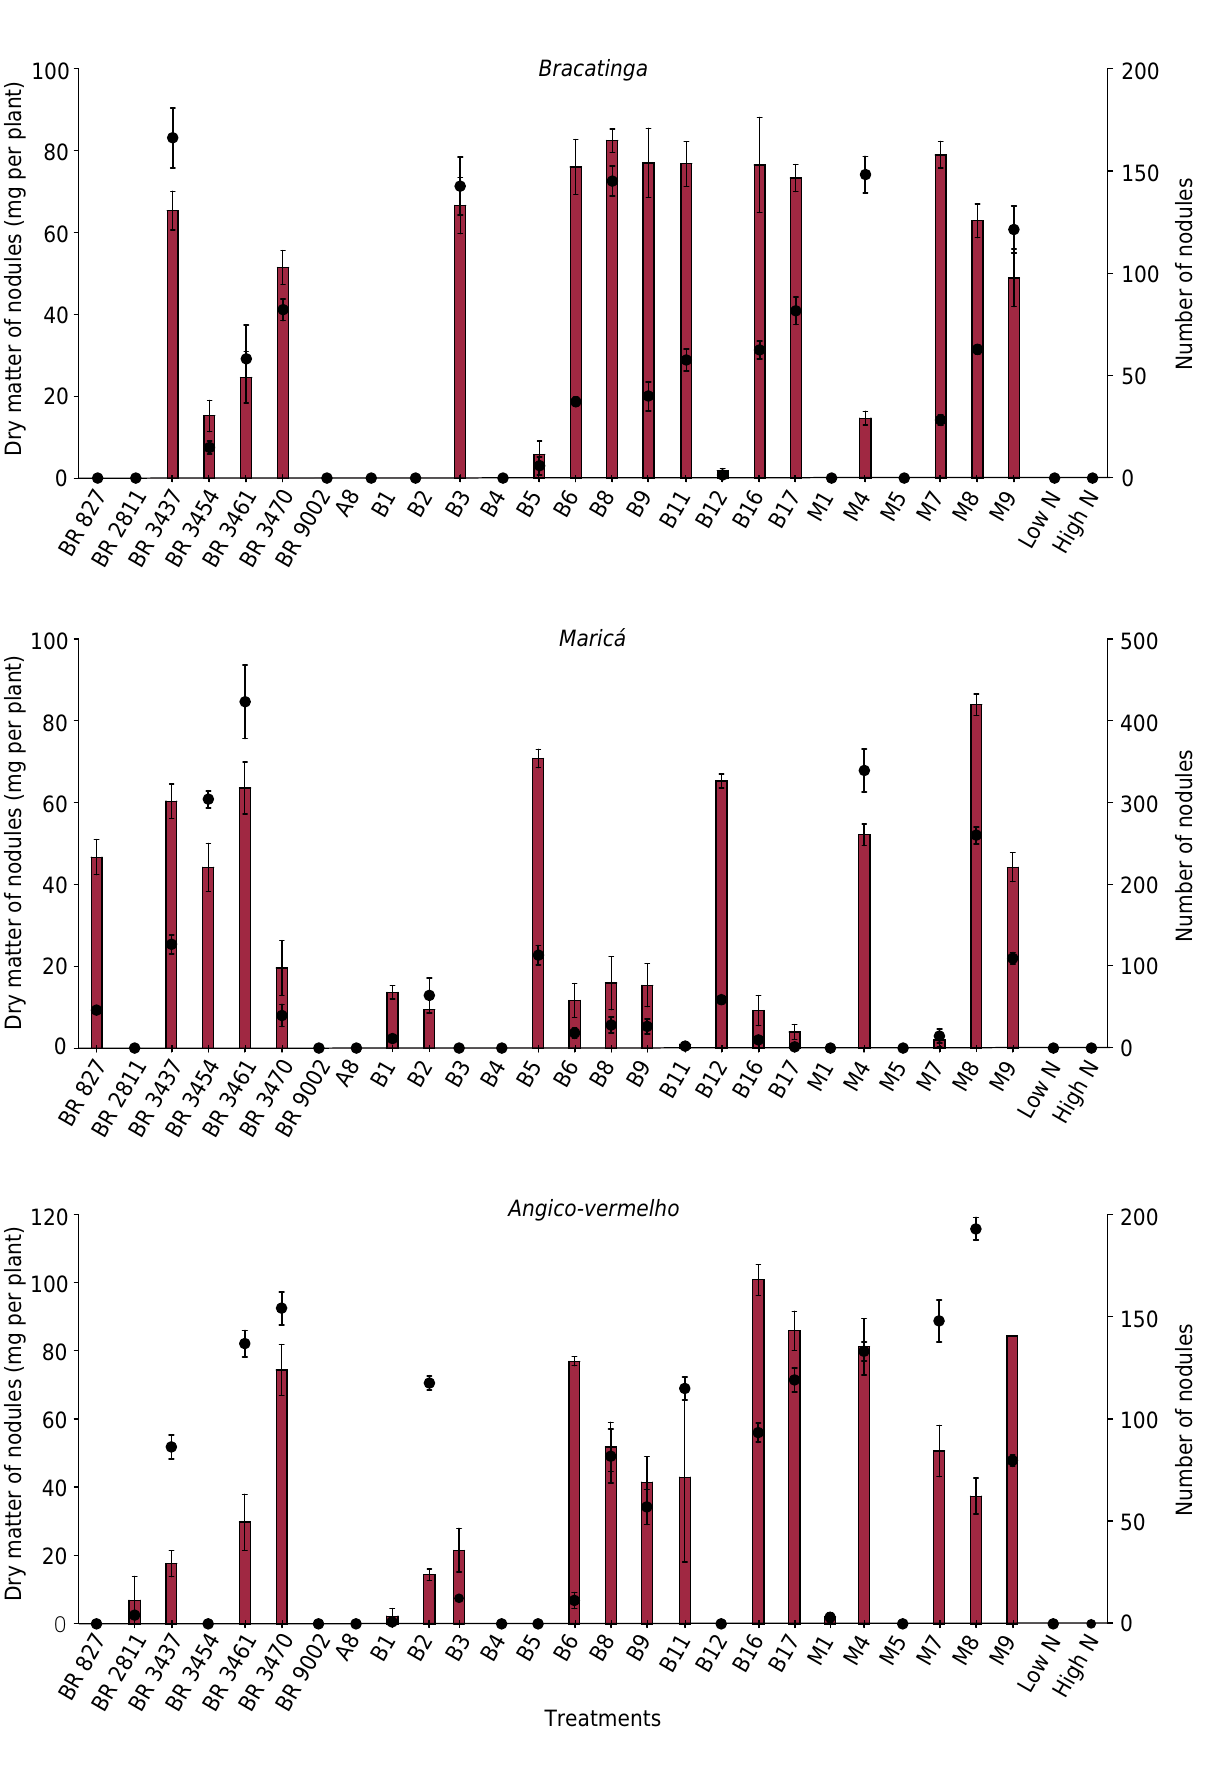
Figure 2. Dry matter (magenta bars) and number of nodules (black circles) from seedlings of bracatinga , maricá and angico-vermelho inoculated with rhizobia indigenous to coal mining areas or with the recommended strains of reference. Vertical bars represent the standard error of the mean (n =